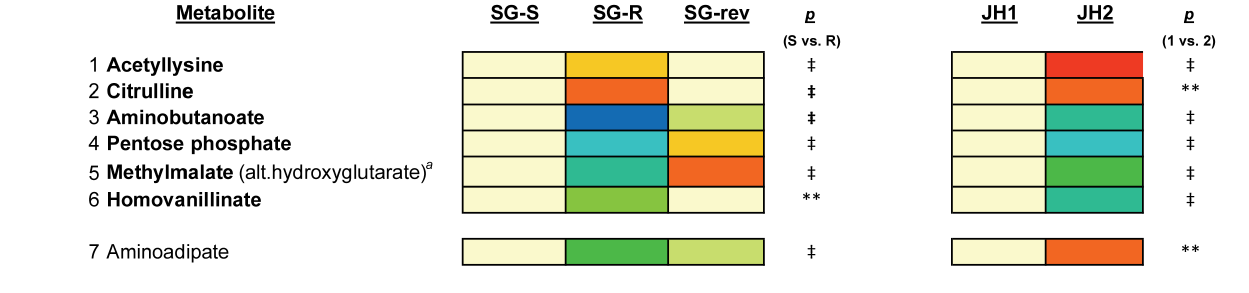
Figure 5. Heat Map of Metabolites In Which Alterations in Intracellular Abundance was Linked to VISA-type Resistance. Heat map displaying the 7 metabolites whose abundance was significantly altered in the VISA isolates from both series (SG-R and JH2) compared against the parent VSSA isolates (SG-S and JH1) and reversed directionality in the revertant, SG-rev, indicating a link to the vancomycin resistance phenotype. Of these seven metabolites, all but one (aminoadipate) changed in a similar fashion in both VISA isolates compared against the parent VSSA isolates. Changes in abundance are indicated by color coding with red indicative of increases in mean intracellular abundance relative to the baseline (defined by the abundance in SG-S) and blue indicative of decreases in intracellular abundance on a log (2) scale. Specific p -values for the comparison of SG-R versus SG-S are denoted to the near right of the heat map. The superscript ( a ) denotes unable to determine if methylmalate or hydroxyglutarate in the absence of a chemical standard.